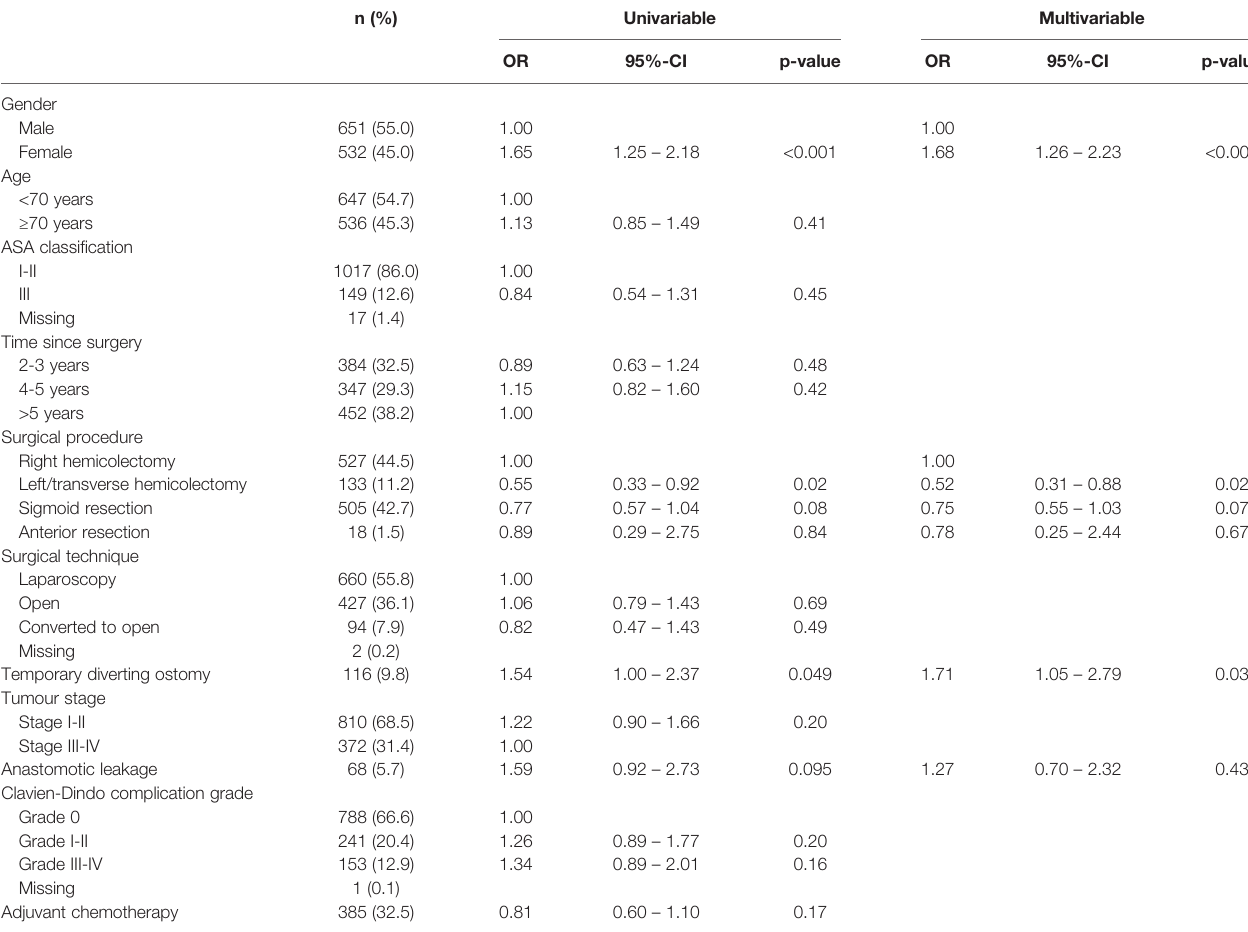
TABLE 4 | Univariable and multivariable logistic regression analyses on associated factors for major LARS in colon cancer patients